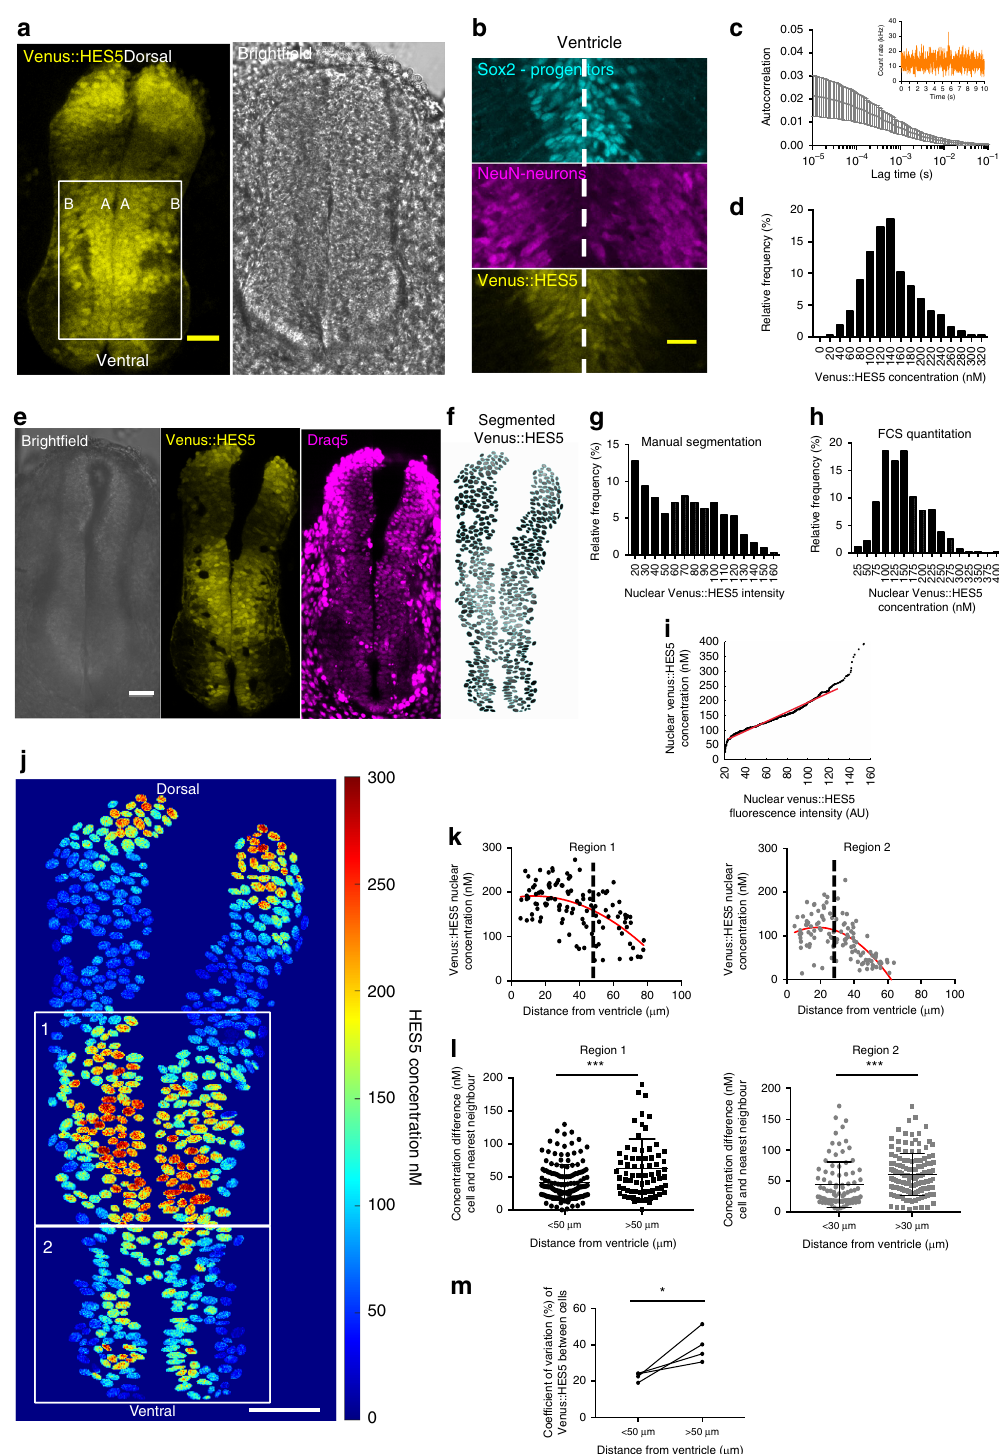
FCS count-rate was minimally affected by auto- fl uorescence (Supplementary Fig. 2b). In Venus::HES5 + / + embryos single cells showed a 10-fold range of nuclear Venus::HES5 protein expres- sion within the ventral Venus::HES5 expression domain, from 26 to 319 nM. (Fig. 1d). The mean Venus::HES5 nuclear con- centration was calculated as 140 nM, or 46,250 molecules per nucleus. Heterozygous embryos showed lower mean protein expression, as could be expected by monitoring the expression of one allele (Supplementary Fig. 2e). These fi ndings show a high NATURE COMMUNICATIONS| (2019) 10:2835